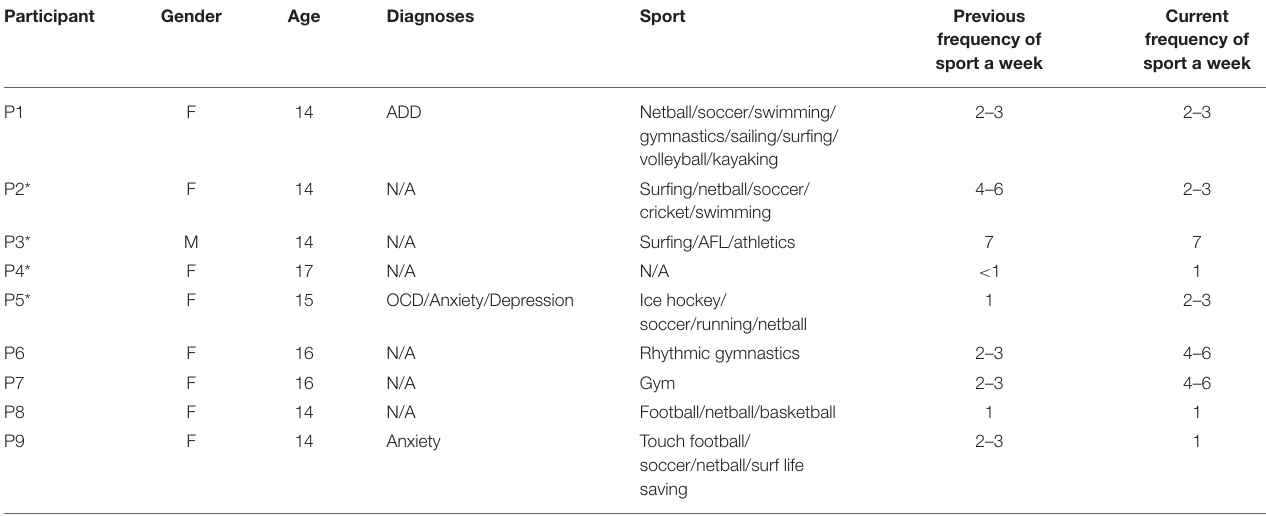
TABLE 1 | Demographic information for participants ( n = 9).